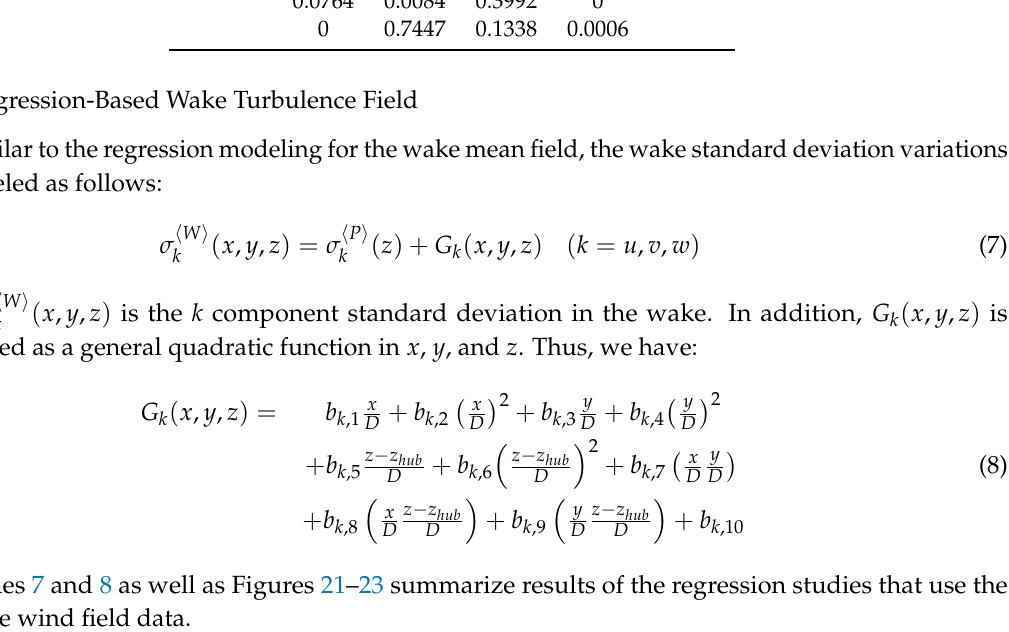
Table 7. G k ( x , y , z ) wake standard deviation regression